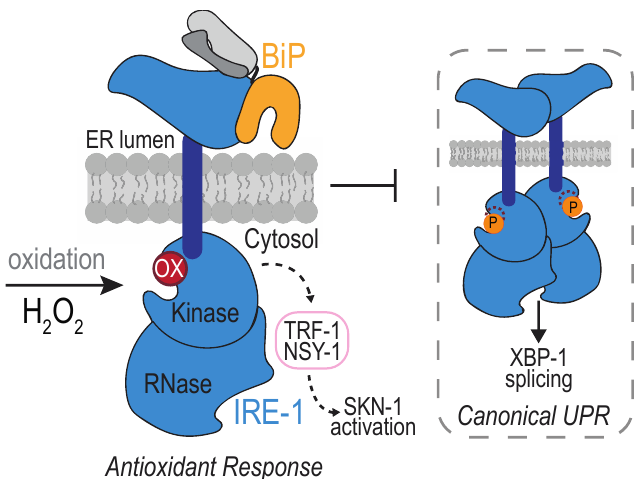
Figure 5. Oxidation of the Caenorhabditis elegans IRE-1 kinase domain inhibits canonical unfolded protein response (UPR) signaling and promotes an antioxidant response. High levels of hydrogen peroxide (H 2 O 2 ) triggers oxidation of a conserved cysteine (red circle) in the activation loop in the kinase domain, which inhibits kinase activity and prevents activation of the RNase domain, preventing canonical UPR signaling. Dissociation of BiP from IRE-1 is normally associated with UPR induction, and BiP remains associated with oxidized IRE-1 [114]. Oxidation results in the recruitment of the scaffold TRF-1 and kinase NSY-1, which mediate initiation of an antioxidant transcriptional response through the transcription factor SKN-1.